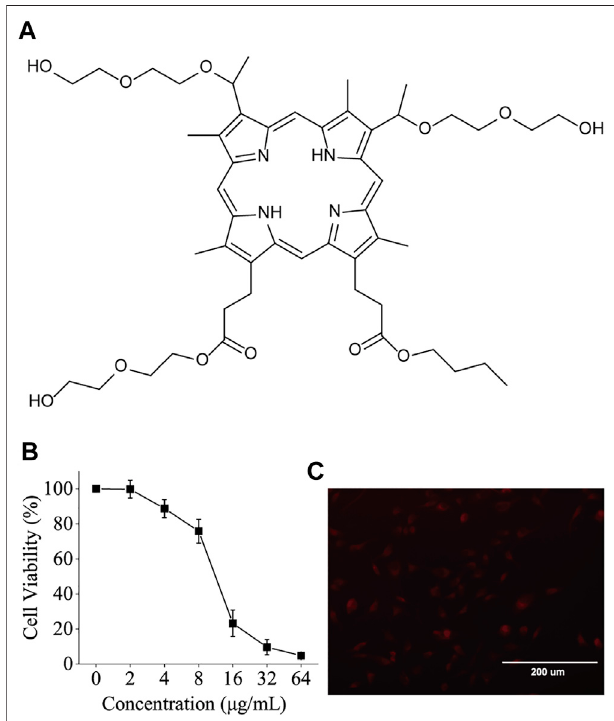
FIGURE 1 | (A) Chemical structure of BBTPP (B) Dependence of BBTPP concentration on the cell viability of PC-9 cells 24 h